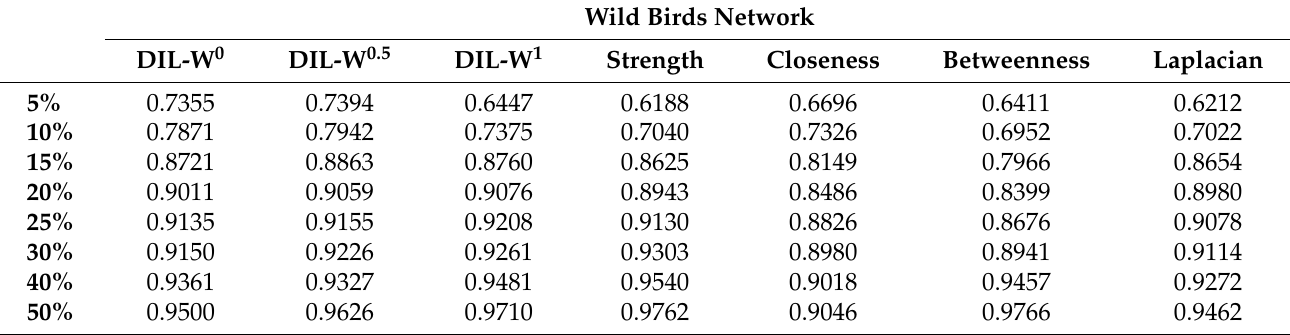
Table A2. σ according to different values of k in Wild birds Network. Wild Birds